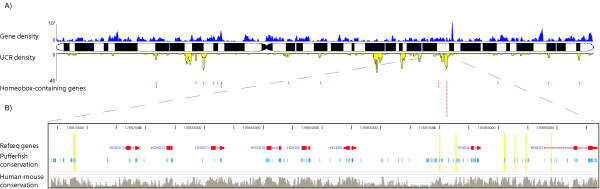
Genomic distributions of UCRs and transcription factor genes. A. Distribution of UCRs on human chromosome 2 is shown in yellow, and total gene density along the chromosome is shown in blue (top track). Note the lack of correlation between gene density and UCR density. Positions of homebox-domain containing genes locations are marked in red, and generally coincide with local maxima of UCR density. The remaining UCR density peaks coincide with genes for transcription factors belonging to structural classes other than homeobox. B. Close-up of a UCR cluster coinciding with the HoxD gene cluster. The HoxD cluster coincides with one of the larger UCR density peaks on chromosome 2, and is associated with nine UCRs. UCR locations are shaded in yellow.